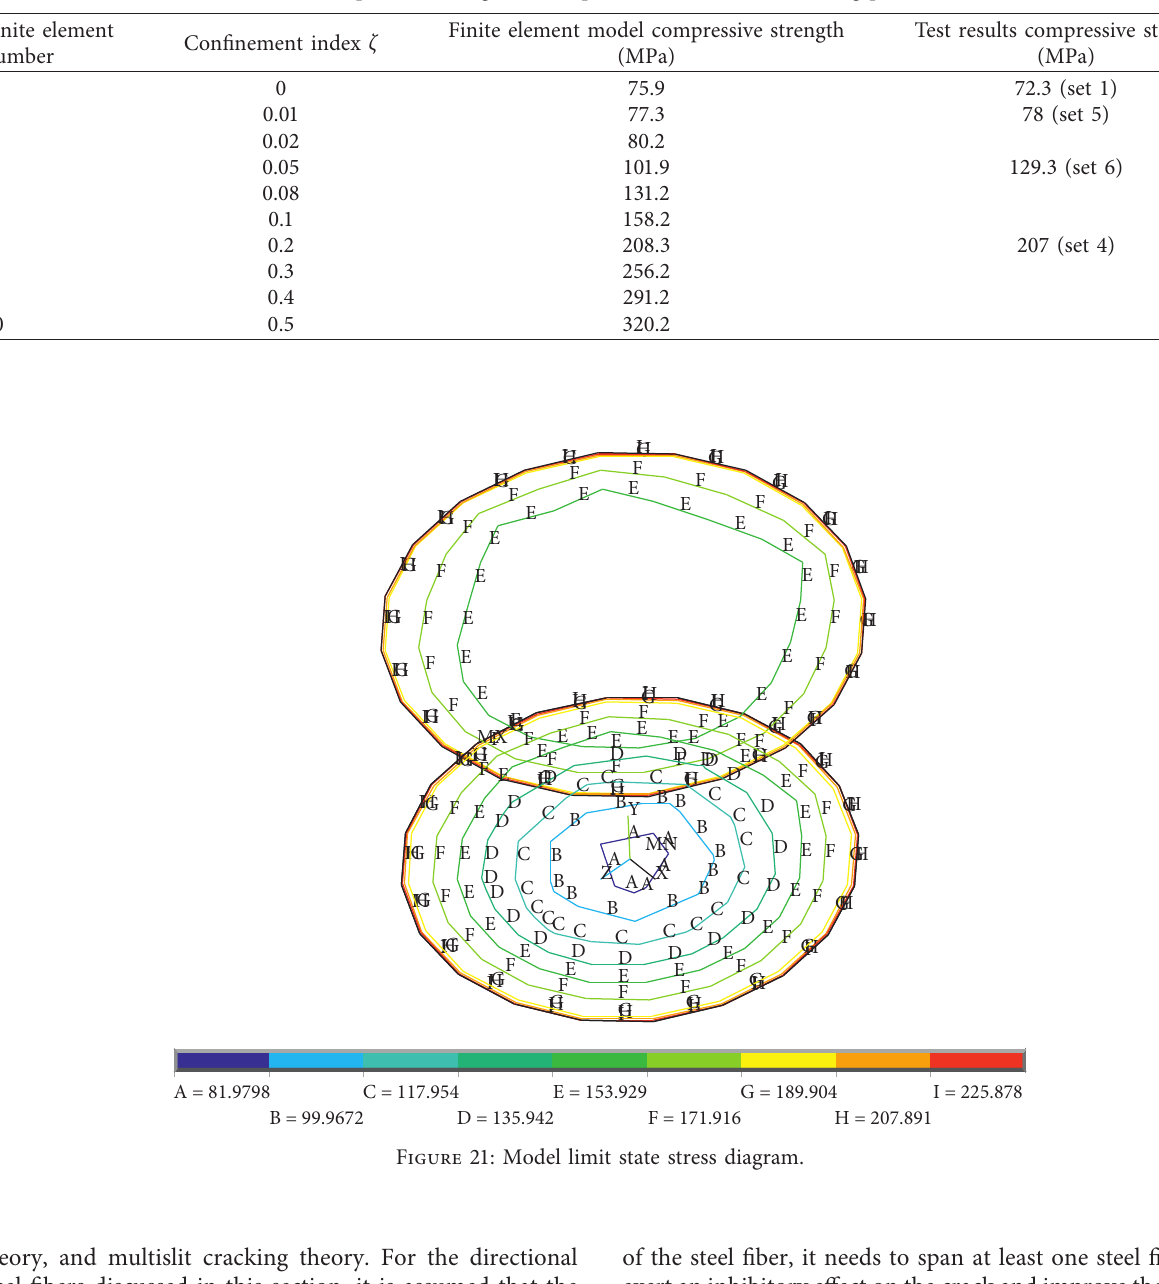
Table 4: Compressive strength of test pieces with different confining parameters.